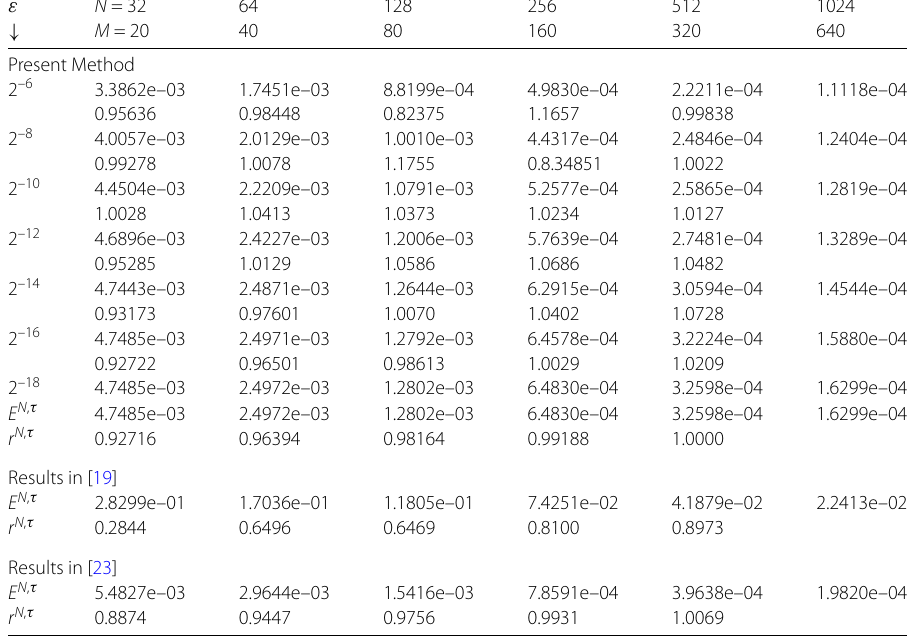
Table 2 E N , τ ε , E N , τ , and r N , τ for Example 5.1